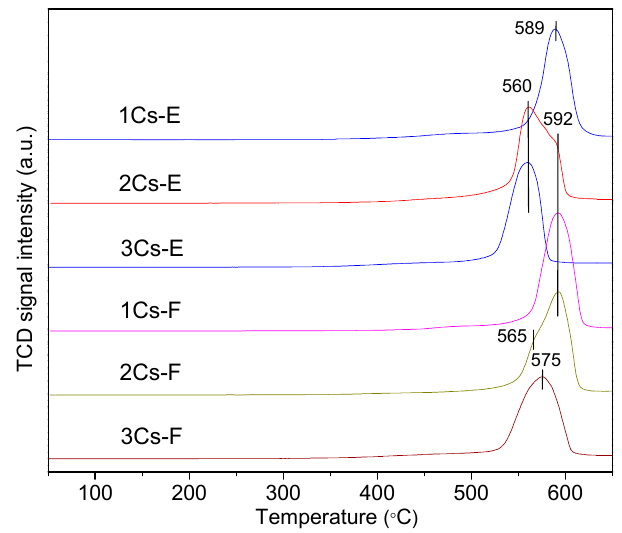
Figure 5. H 2 temperature ‐ programmed reduction (H 2 ‐ TPR) profiles of the samples.